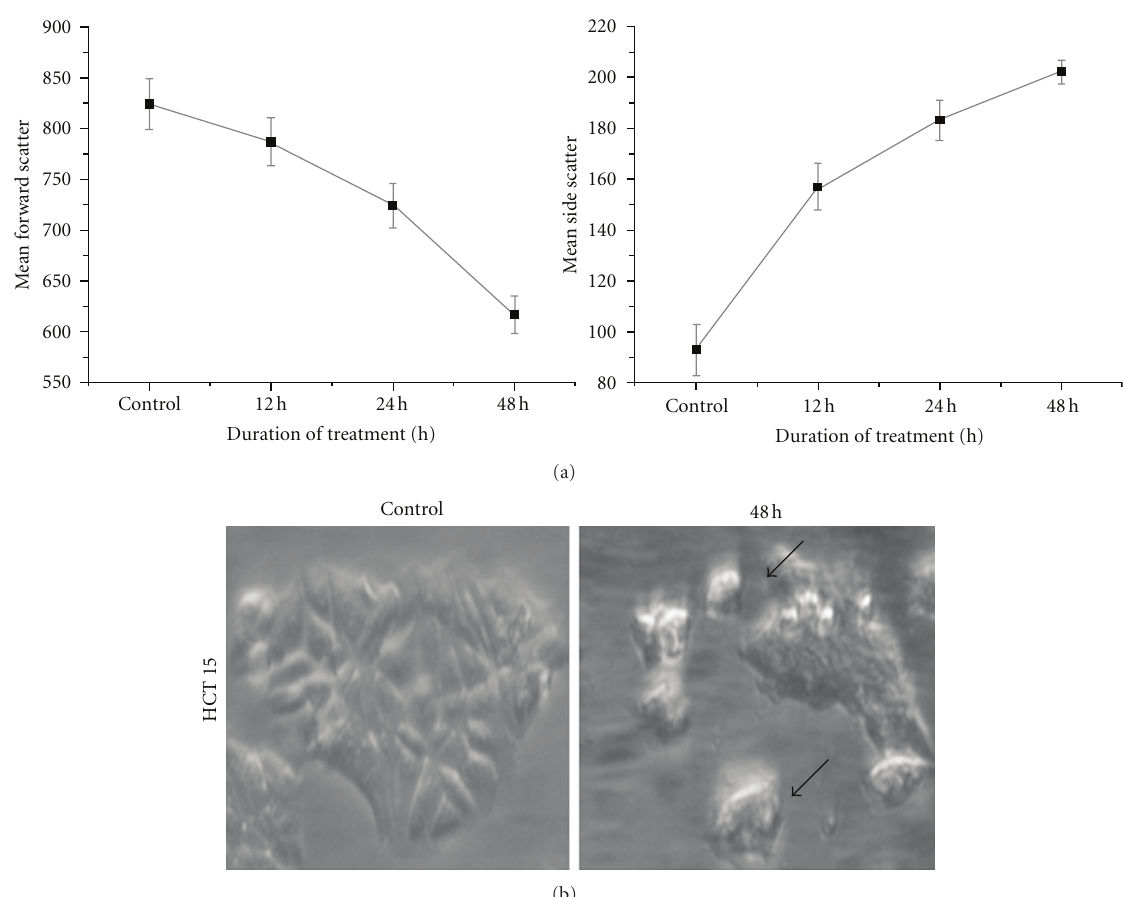
Figure 2: Changes to cell size and granularity distribution of ca ff eic-acid-treated cells. (a) Flow cytometric determination of cell forward and side laser light scatter was used to determine the relative changes to cellular size and granularity of HCT 15 cells after 12, 24, and 48 h of ca ff eic acid treatment. Data are mean ± S.E from the three independent experiments. (b) Photomicrograph of ca ff eic-acid-treated cells was acquired along with the untreated control cells after 48h. Treated cells showed shrinkage compared to the normal cells as shown by arrow mark.